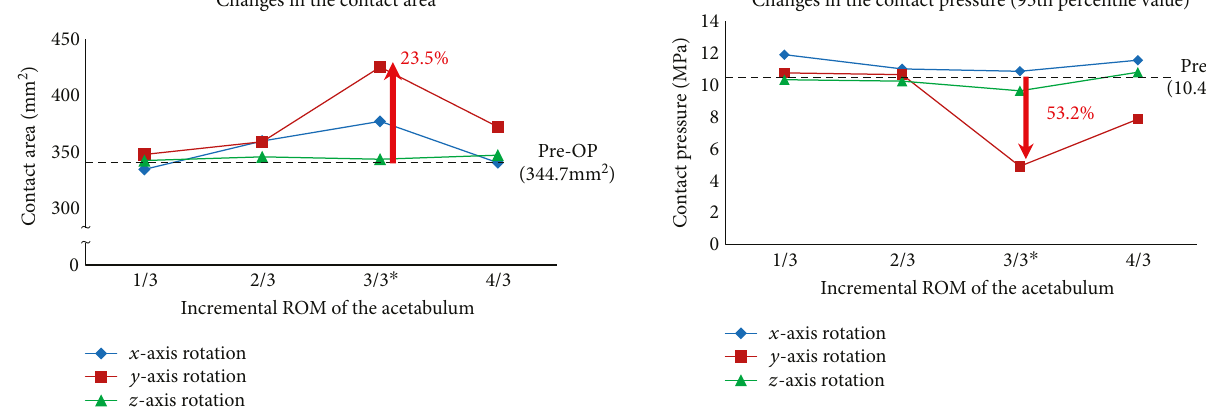
Figure 5: Changes in the contact area as a function of incremental increased rotations of the acetabulum as compared to the Pre-OP condition. The “ ∗ ” sign indicates the actual acetabular rotation (ACR) during the surgery.